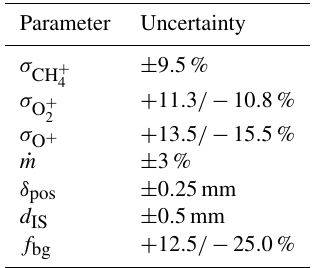
Table A1. Parameters considered in the uncertainty analysis.